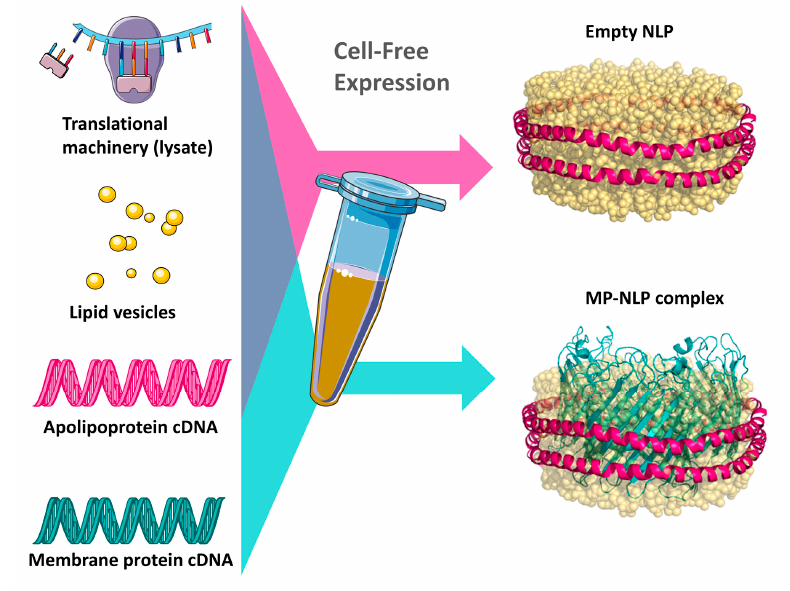
Figure 2. Cell-free expression and self-assembly of empty nanolipoprotein particles (NLPs) (pink arrow) and NLPs with embedded transmembrane proteins (teal arrow).